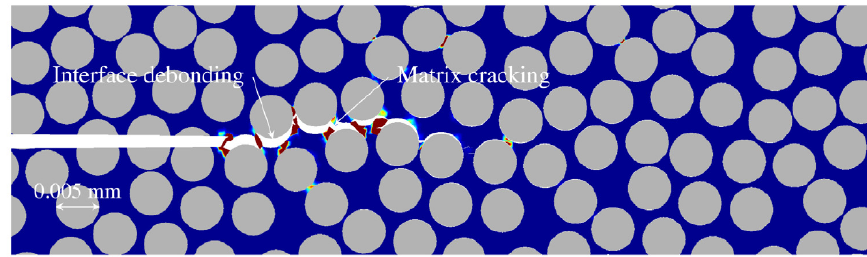
Figure 8. Microcracking in glass fiber-reinforced polymer composites